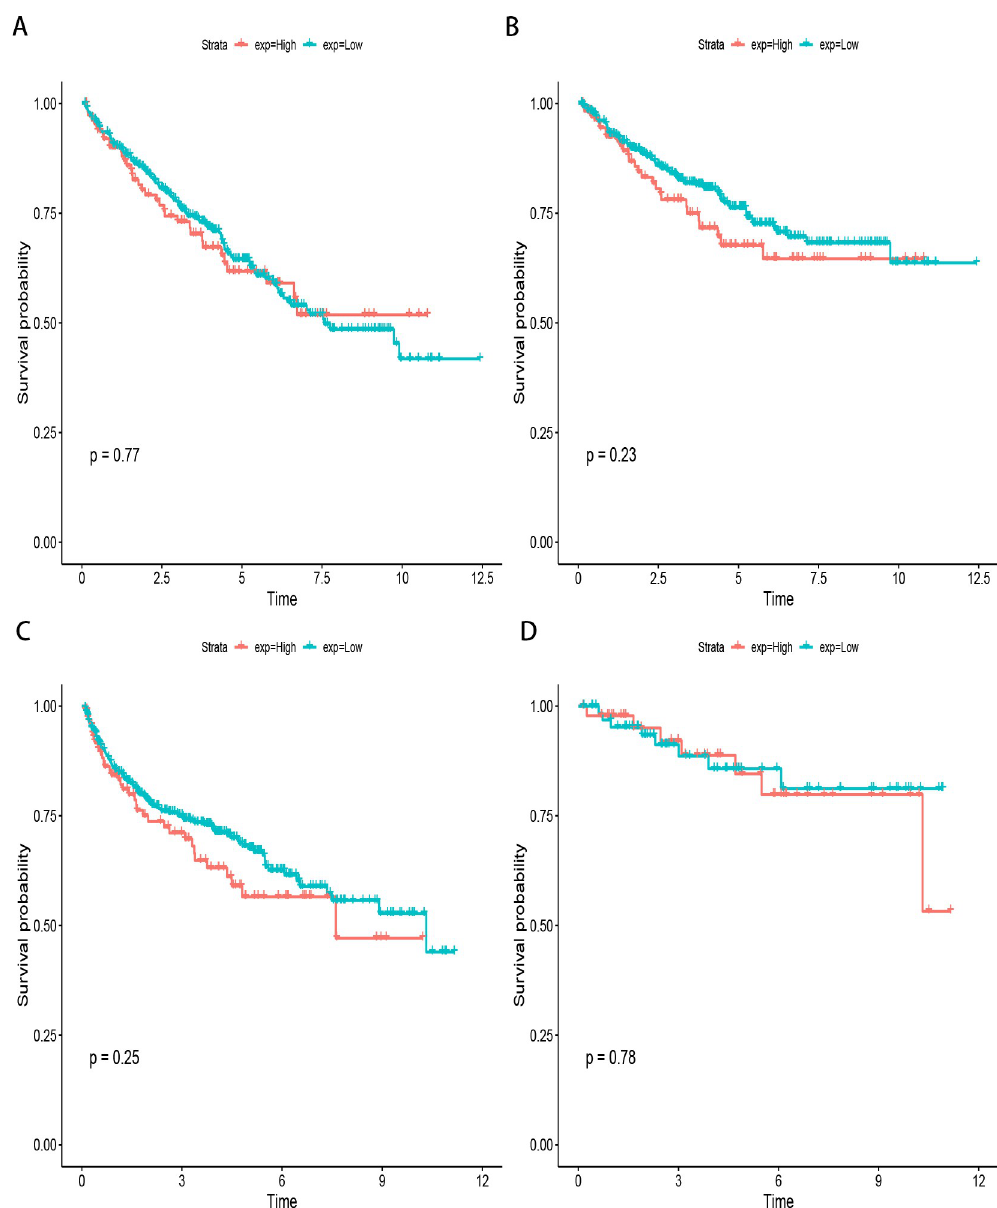
Fig 12. Bioinformatic analysis based on TCGA database. A, Kaplan-Meier survival analysis between CAIX expression and overall survival; B, Kaplan-Meier survival analysis between CAIX expression and disease-specific survival; C, Kaplan-Meier survival analysis between CAIX expression and progression-free interval; D, Kaplan-Meier survival analysis between CAIX expression and disease-free interval.